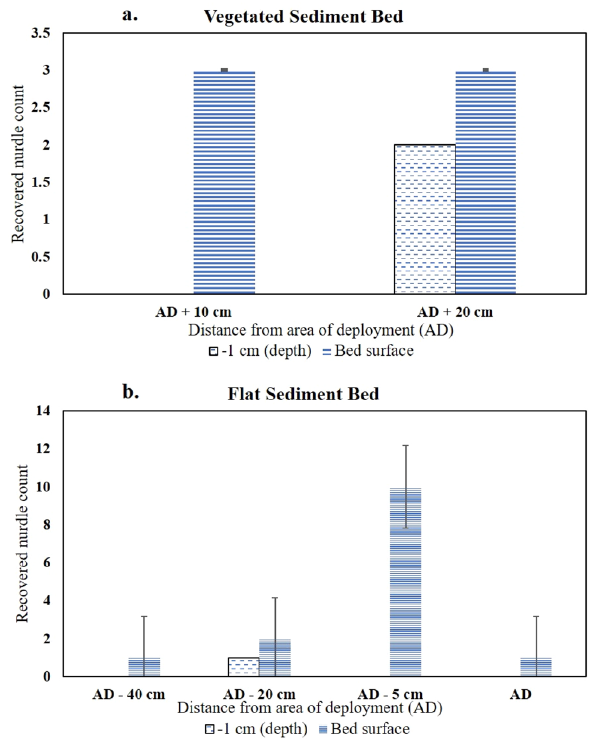
Figure 6. Number of nurdles recovered from post-experiment cores and their depths for ( a ) vegetated sediment bed (Test B) and ( b ) flat sediment bed (Test C). AD means Area of Deployment; the negative sign means upstream (against the water flow direction) and positive sign means downstream (in the direction of the water